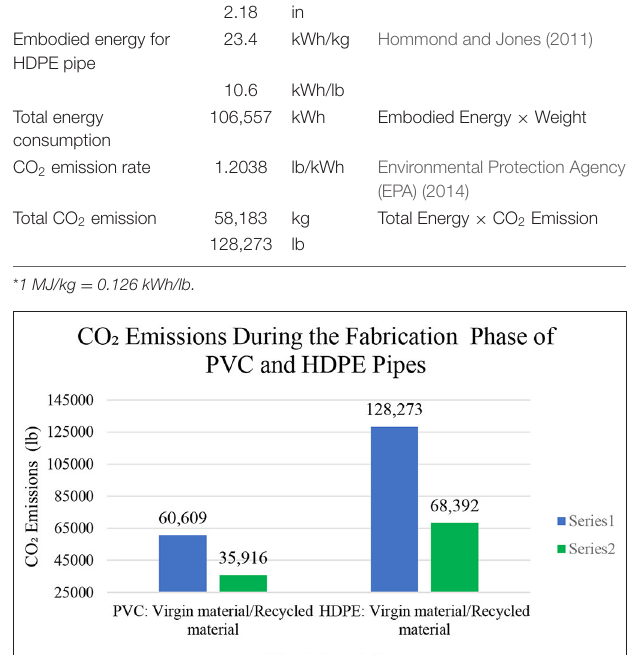
FIGURE 3 | Comparing the carbon emissions between virgin VS. Recycled materials for PVC and HDPE pipes. kWh/lb.) (ICE, 2011). In the open-cut method, in using the concrete pavement, the CO 2 emissions are 3,096 kg (6,826 lb);